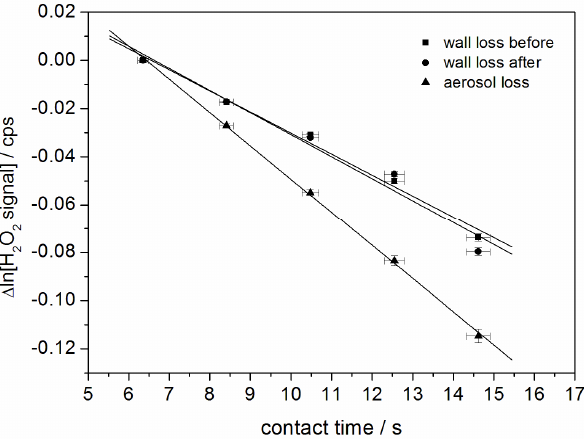
Fig. 3. An example of a heterogeneous kinetic run of H 2 O 2 uptake by Gobi dust aerosol at 35% RH in the aerosol flow tube. The lines show 2 σ error-weighted least-squares fits to the data from which first-order rate constants are determined. Error bars on the H 2 O 2 signal are 2 σ standard deviation of the noise level in the measured signal. Error bars on contact times result from ± 2% uncertainties in the flow rate measurements.